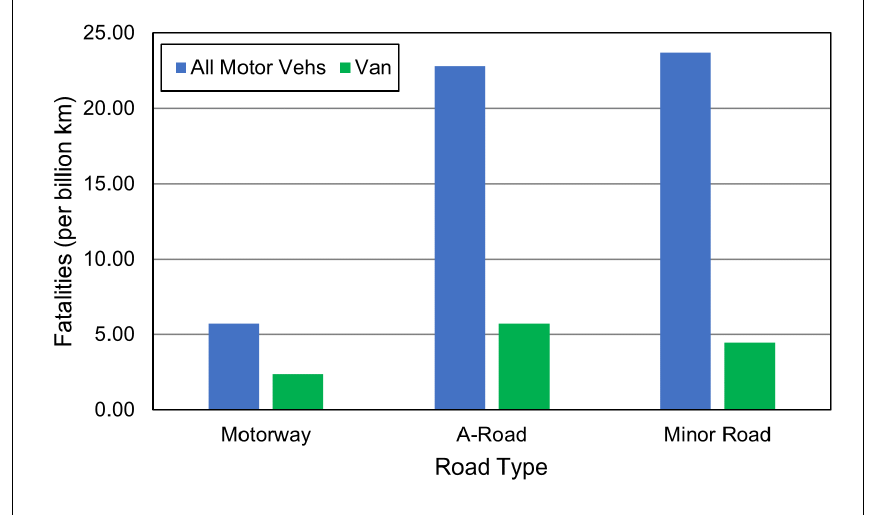
Figure 4. Road Types Fatality Rates